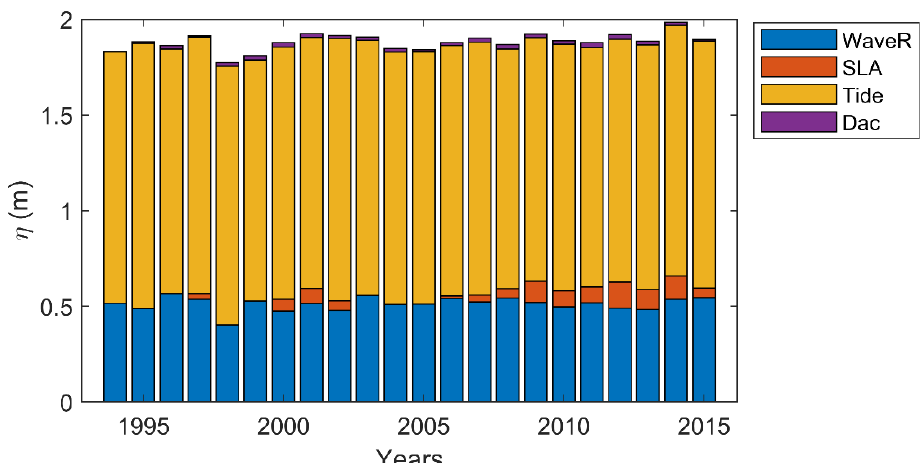
Figure 3. Contribution of each model parameter described in Equation (2) for the extreme sea levels exceeding the 98% percentile threshold value at Dakar, between 1994 and 2015.